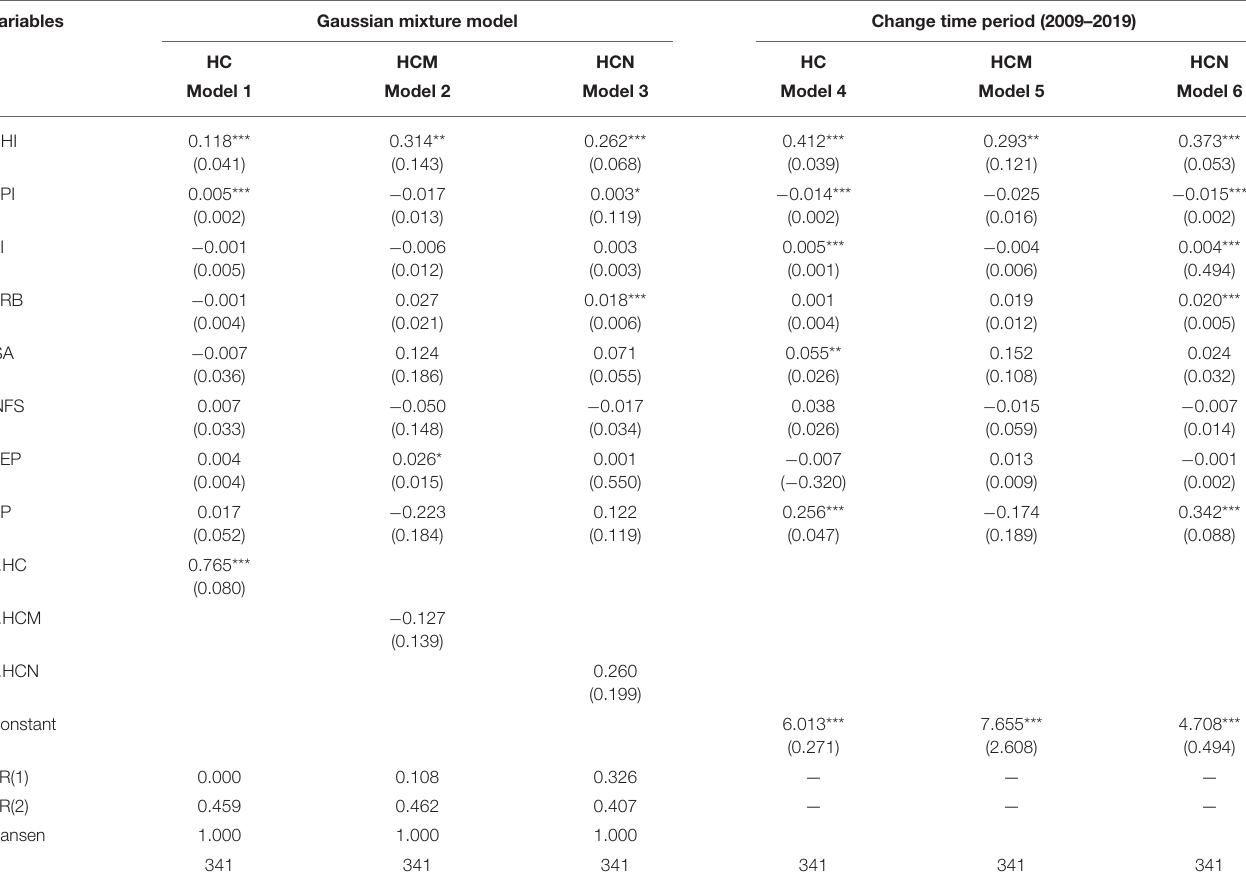
TABLE 7 | Robustness